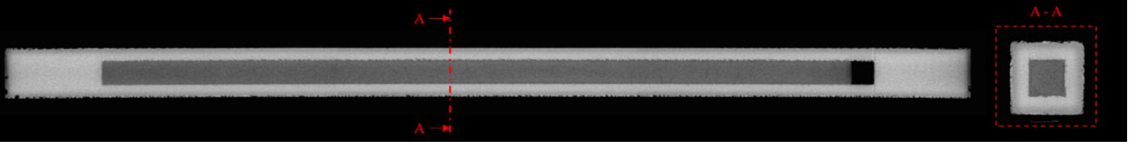
Figure 9. CT scan of a powder-filled beam made from 1.2709, outer dimensions: 8.4 × 8.4 × 169 mm 3 , parameter 43, material: